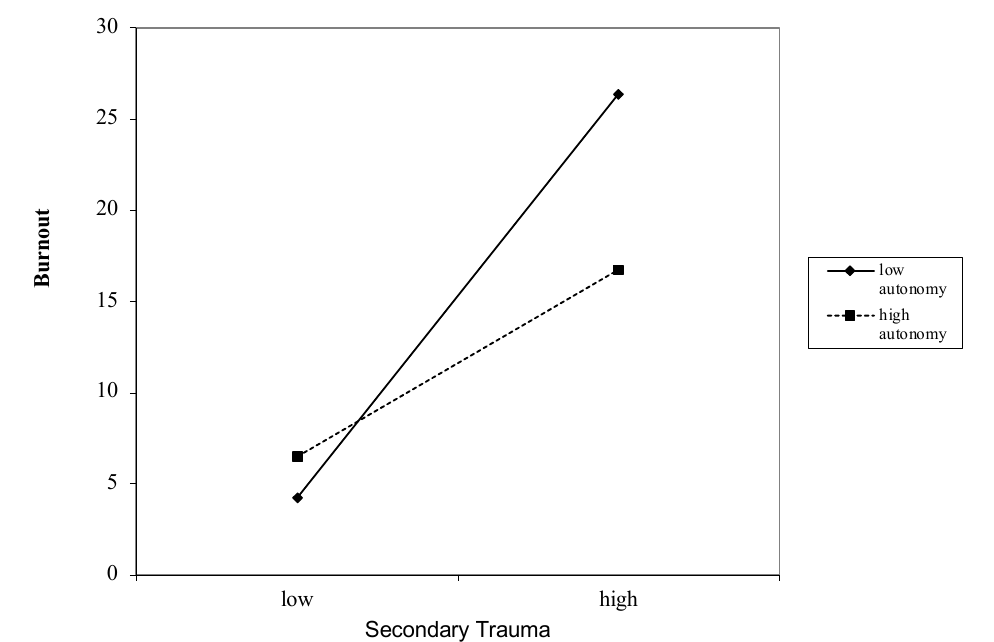
Figure 1. Graph of interaction plot between secondary trauma and autonomy. Perceived autonomy moderates the relationship between secondary trauma and burnout, such that those with low autonomy (1 SD below the mean) and high secondary trauma reported greater burnout.